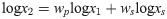
Comparison of statistical predictions against experiments of social influence.(A) Probability distribution of estimations before (no info, blue) and after (full info, red) receiving the estimations made by other members of the group. Estimations are pooled from 24 different experiments obtained using different groups and questions, and are plotted together using a z-score, z ≡ (log(x)-μ
p)/σ
p, with x the estimation and μ
p and σ
p the mean and standard deviation before social interactions for each experiment. Points are experimental frequencies sampled at intervals of width 0.25 and solid line is a Gaussian fit. Shadowed surface is the area in which 95 per cent of the experiments are expected by the Gaussian fit. The statistical prediction is that after social interactions the distribution of answers is also a Gaussian in the logarithmic domain with the same mean and smaller standard deviation. (B) Same as (A) but before (no info, blue) and after (aggregated info, red) giving subjects the mean of the estimation of all subjects. The statistical prediction is that after social interactions the distribution of answers is also a Gaussian in the logarithmic domain with higher mean and smaller standard deviation. (C) Real vs predicted estimations after social interactions from Eq 4 as  logx2=wplogx1+wslogxs using ws=0.53. Different colors correspond to the six estimation tasks. (D) Distribution of experimental social weights with Gaussian kernel smoothing (see Methods). Data taken from Lorenz et al. [9]